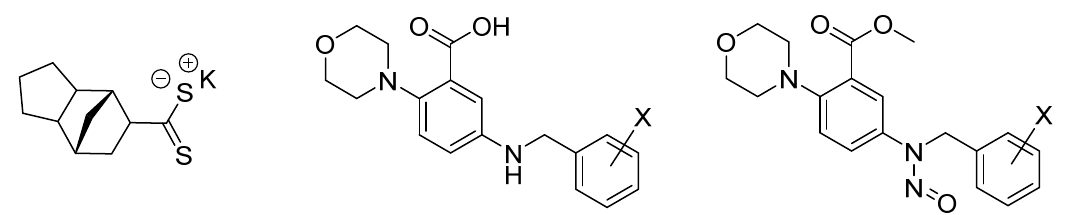
Figure 1. Structures of D609 ( left ) and 2-morpholinobenzoic acids ( centre ) compared to N -nitrosylated benzylamines ( right ) investigated in this study. X = H, F, Cl, Br,